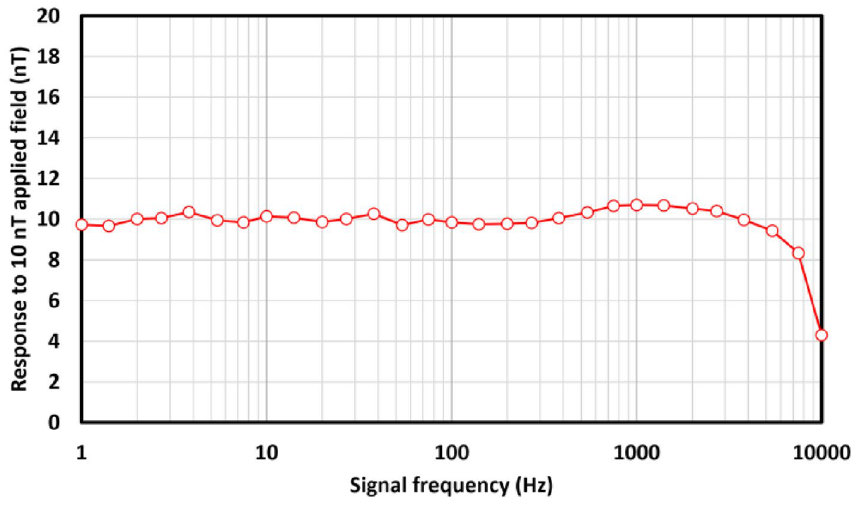
Figure 4. Measured sensor signal amplitude response to 10 nT oscillating applied fields at varying frequencies up to the acquisition frequency Nyquist limit of 10 kHz (20 ks/s). The oscillating field is applied parallel to the static B 0 field ( 50 µ T